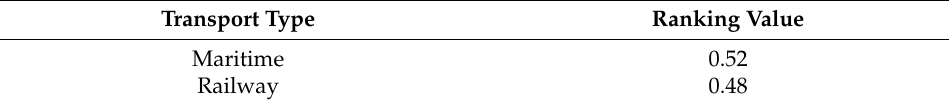
Table 8. Ranking